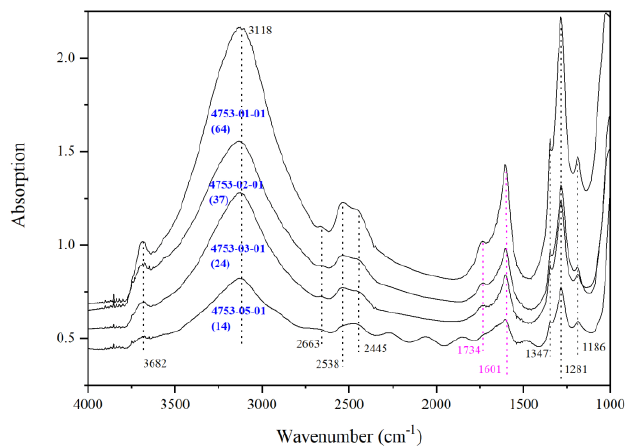
Figure 5. Typical unpolarized IR spectra taken on four crystal plates made from the high-H 2 O Mg-Rw in Run 4753. The IR # is followed by the measured thickness of the crystal plate ( D m in parentheses). Note the interference fringes around ~2150 cm − 1 in the spectrum 4753-05-01, which can be used to calculate the thickness.